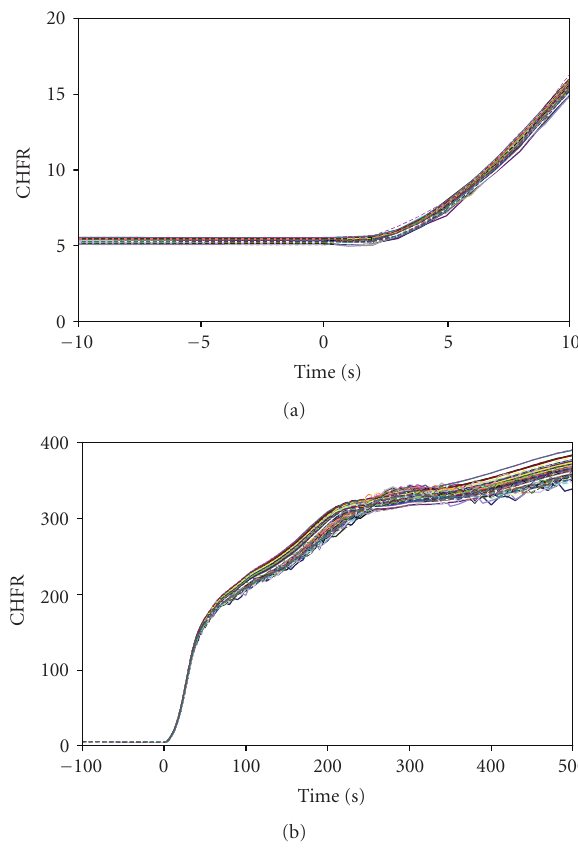
Figure 10: Loss-of-all-MCPs event. CHFR in case of all MCPs trip.